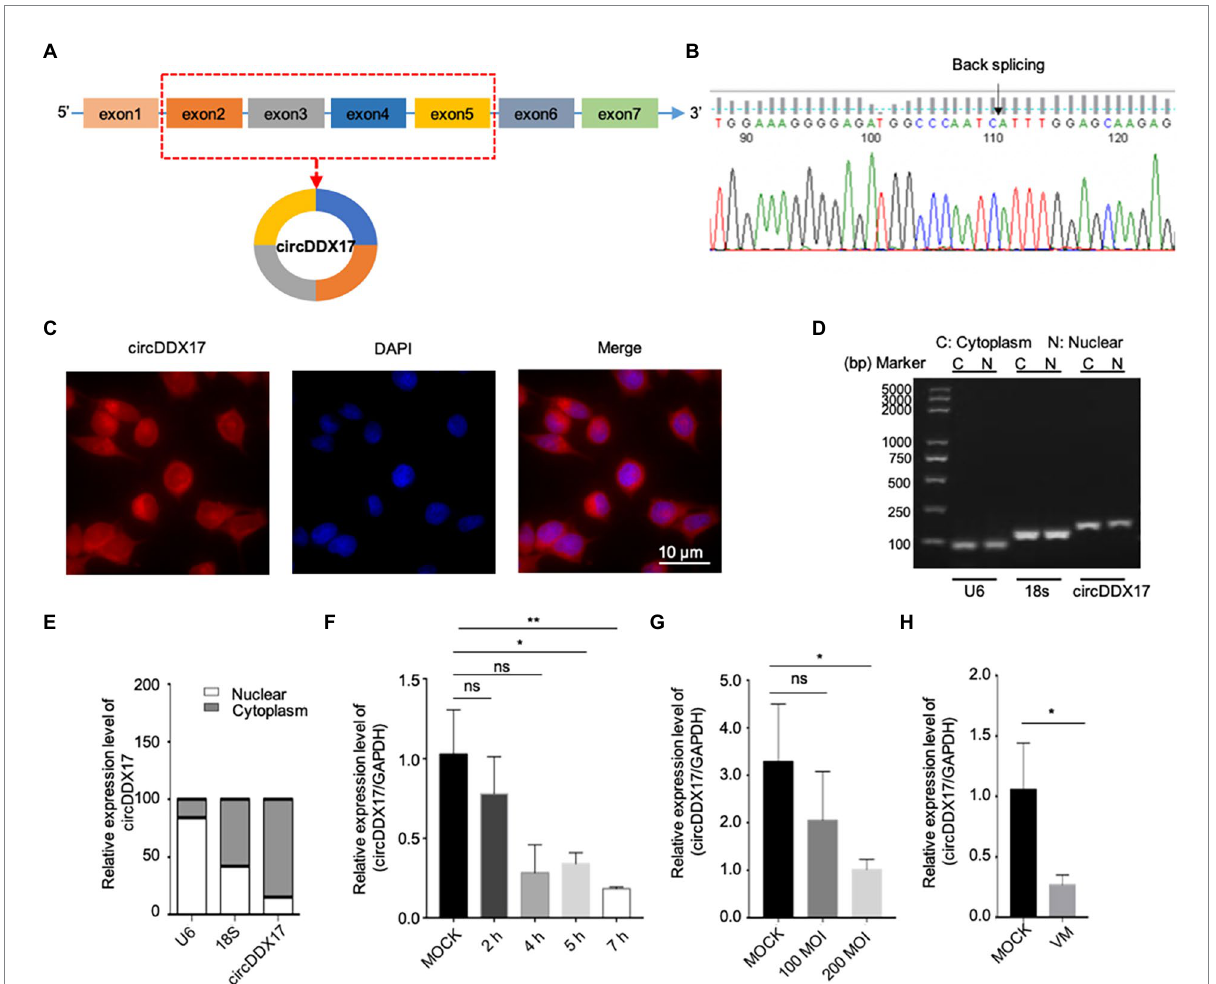
FIGURE 1 Characterization and subcellular distribution of circDDX17 in HeLa cells. (A,B) . Sanger sequencing confirmation of the head-to-tail splicing of circDDX17. (C–E) The sub-cellular distribution of circDDX17 was mostly present in the cytoplasm by the nuclear mass. (F) RT-qPCR analysis of circDDX17 expression in HeLa cells 7 h after CVB3 infection. (G) RT-qPCR analysis of circDDX17 in CVB3-infected HL-1 cells (100 MOI and 200 MOI) for 24 h. (H) RT-qPCR analysis of circDDX17 in viral myocarditis, MOCK mice were as control. * p < 0.05, ** p <